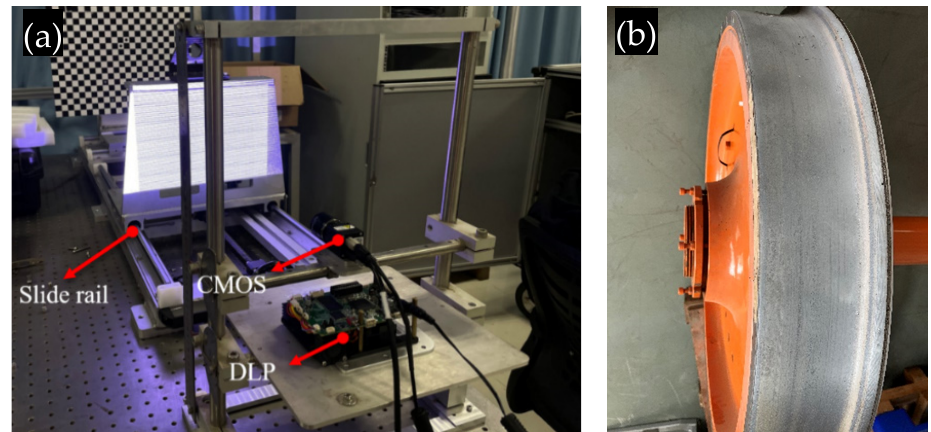
Figure 2. ( a ) Experimental system; ( b ) the measured wheel tread object.